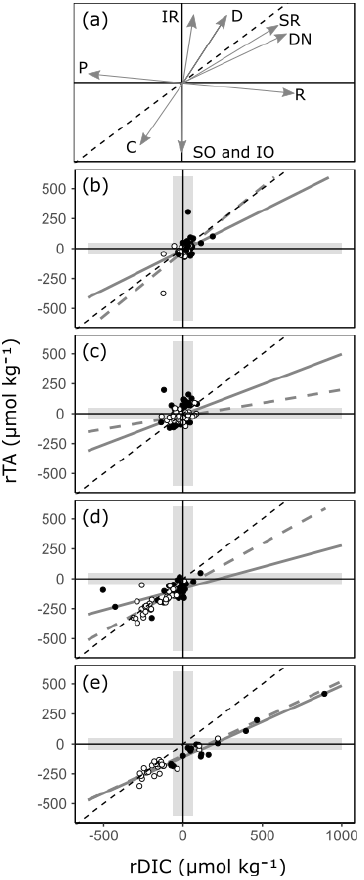
Figure 8. A reference plot (a) showing unitless directional vectors of change in the rTA vs. rDIC space for multiple ecosystem pro- cesses. Below, observations of rTA vs. rDIC from transition water and the three coastal habitats are presented: (b) transition water, (c) coral reef, (d) seagrass meadow and (e) mangrove forest. Time series observations are indicated with open circles, and all other spatial data are indicated with closed circles. A 1:1 reference line is shown in all plots (black dashed line) as well as regression lines ( r 2 > 0 . 6) for the time series subset (grey dashed line) and the spa- tial subset (grey solid line). The reference plot includes directional vectors for calcium carbonate precipitation ( C ), calcium carbon- ate dissolution ( D ), primary production ( P ), respiration ( R ), iron reduction (IR), sulfate reduction (SR), denitrification (DN), sulfur oxidation (SO) and iron oxidation (IO). The shaded envelope rep- resents the calculated 99% PI for rTA and rDIC. An expanded ver- sion of panel (e) showing inland mangrove stands is presented in Fig.